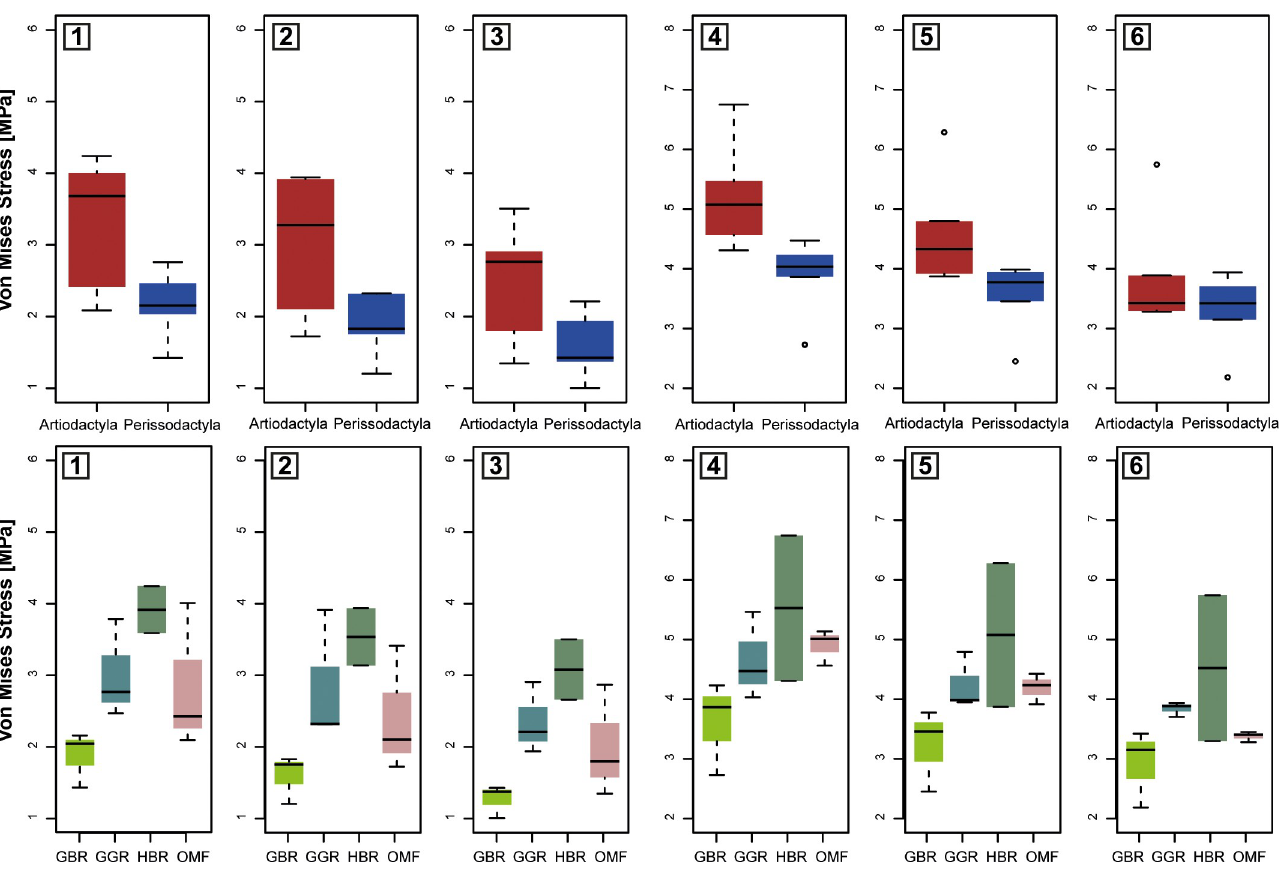
Fig 4. Boxplots of averaged stress MWAM values of all species grouped by order (Artiodactyla and Perissodactyla) and by dietary categories (GGR: General grazer, GBR: General browser, OMF: Open-habitat mixed-feeder and HBR: High-level browser). Lateral cases 1) in M1 2) in M2 and 3) in M3. Orthal cases 4) in M1 5) in M2 and 6) in M3. Central line is the median, whiskers represent the range.